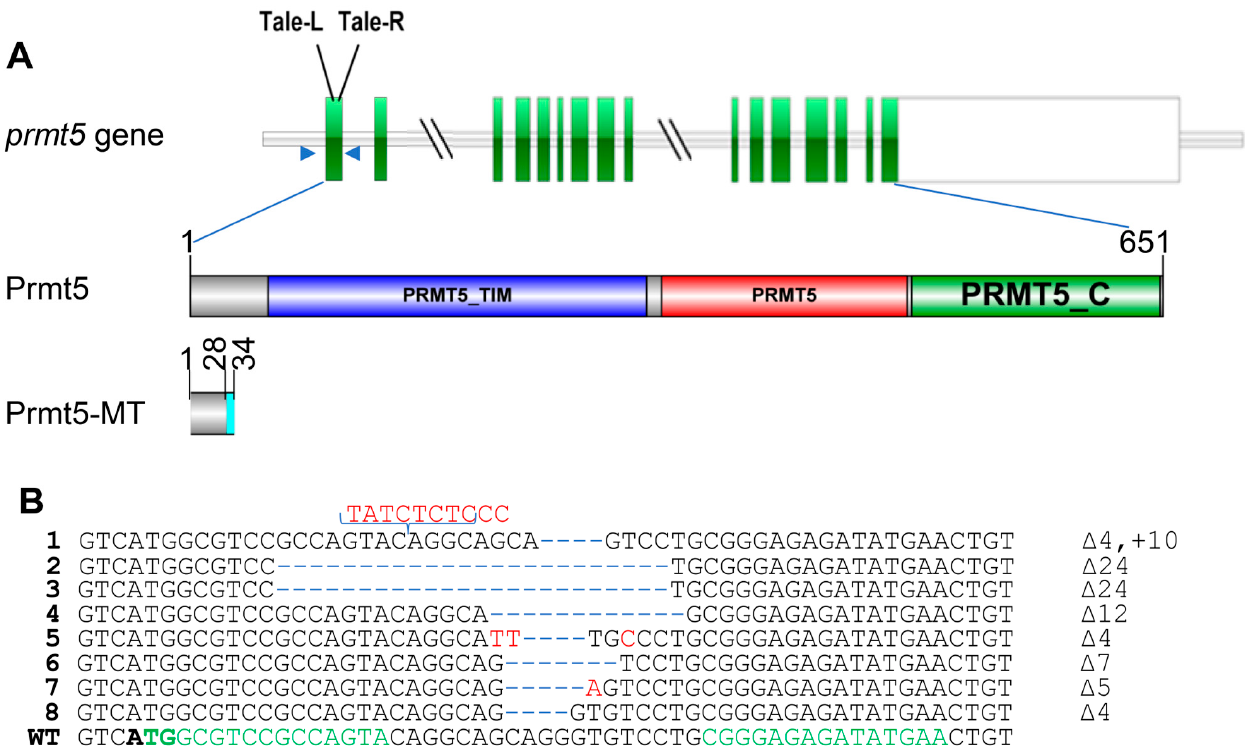
Figure 1. ( A ) Schematic structure of medaka prmt5 gene and proteins. The blocks indicate the exons. The open reading frame (ORF) is shown in green. The arrowheads present the position of the primers used for screening. The target sites of the Tale-L and Tale-R are shown. The full protein of Prmt5 in the length of 651 AA is shown with the functional domains. Prmt5 -MT presents the mutant protein with 34 AA in length. The gray fragment is the same as it is in the full protein. The cyan fragment is deduced from the mutant sequence. ( B ) Alignment of the prmt5 sequences in the founder embryos indicating the insertion and deletion (indel) after microinjection of the TALEN constructs. WT, wild type. The green letters indicate the left and right TALEN targets. The dash or ∆ indicate the deletion, the red or + indicate the insertion. The start codon is in